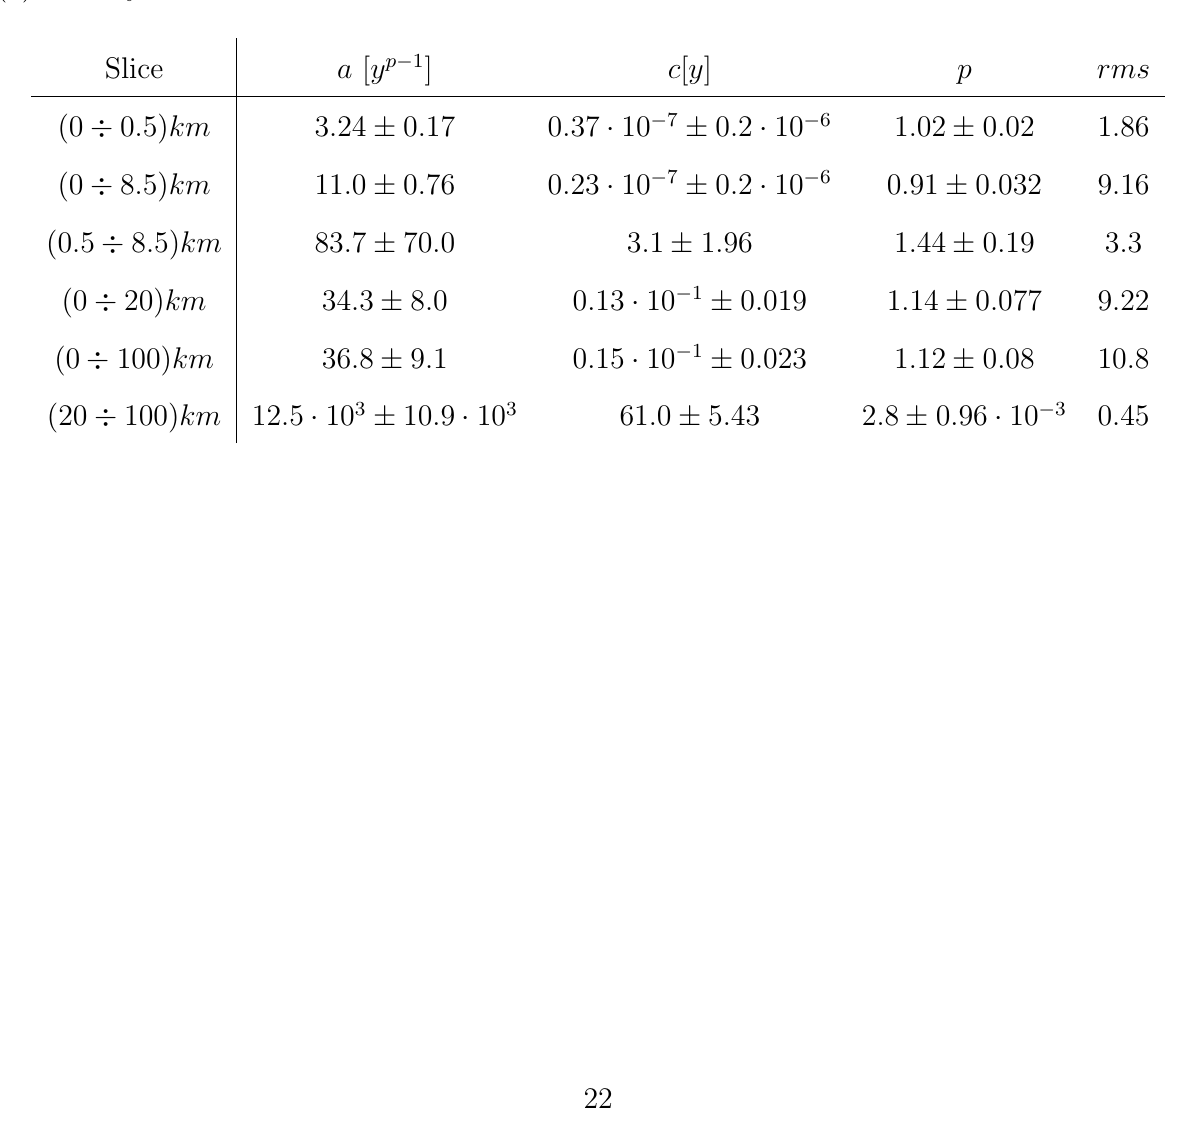
Table 7: Results obtained for the best-fit of the sets of data reported in Figure 5 by the relation (9). The symbol rms indicates the standard